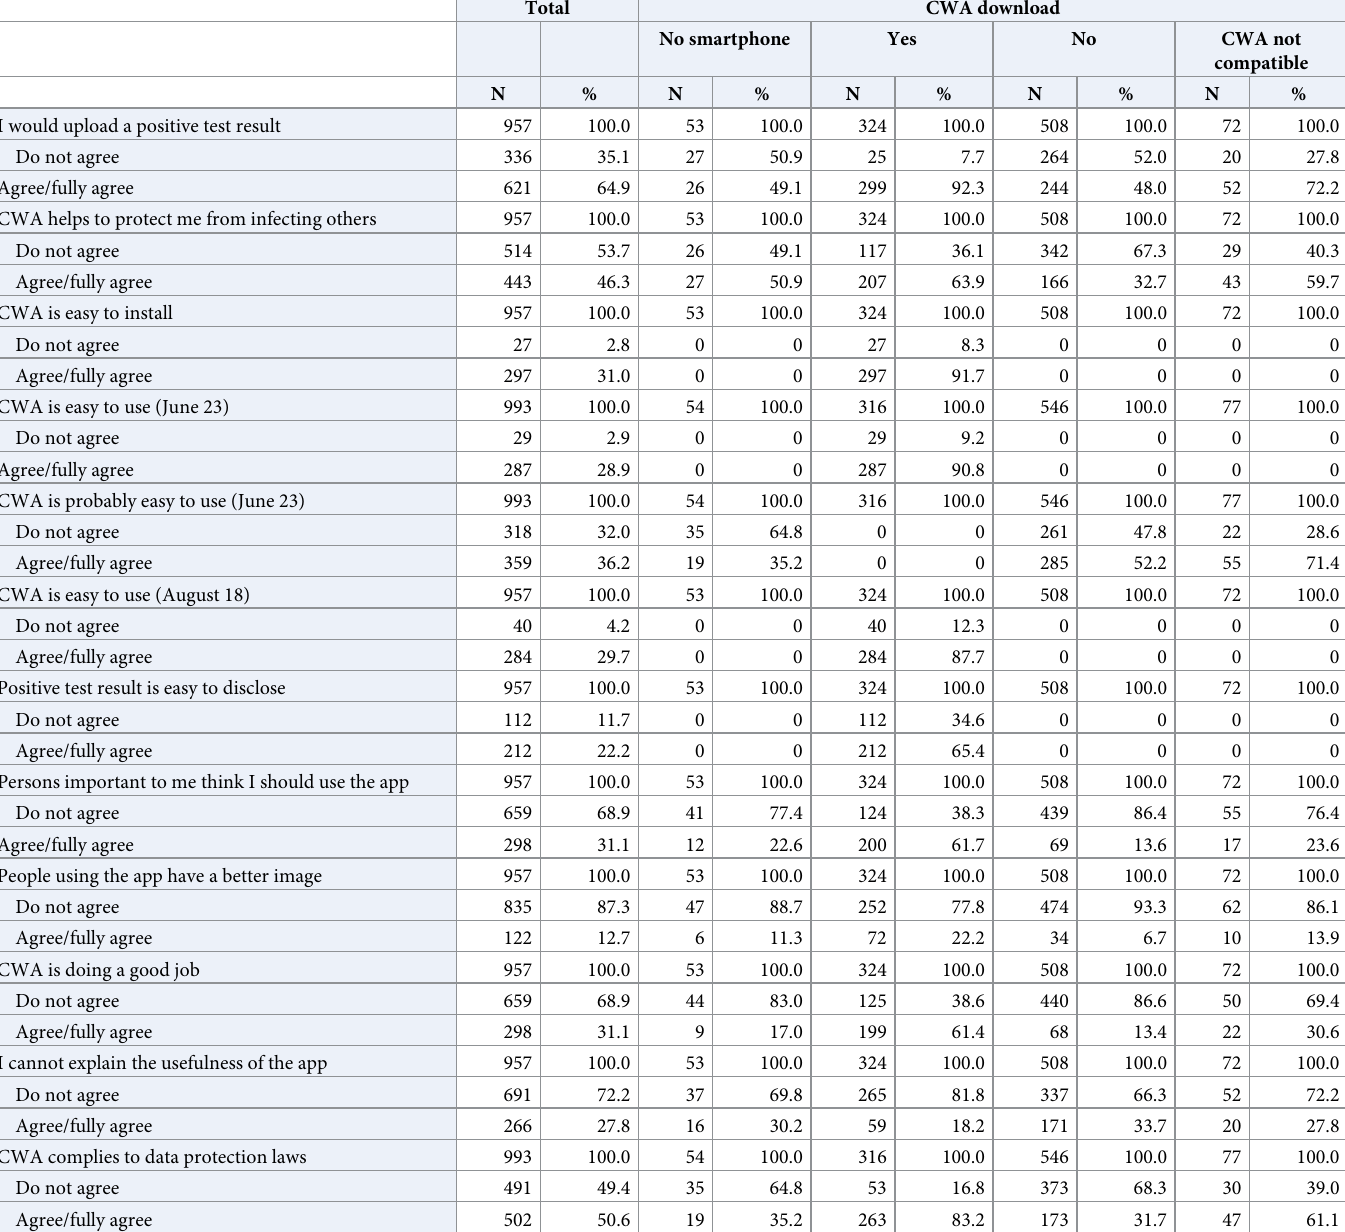
Table 3. Information on use, functionality, and consequences of Corona Warn App (CWA). Items were selectively applied in single waves. Some items were adminis- tered either to persons who had confirmed download (“is easy to use”, “is easy to install”, “Positive test result is easy to disclose”) or who did not download (“is probably easy to